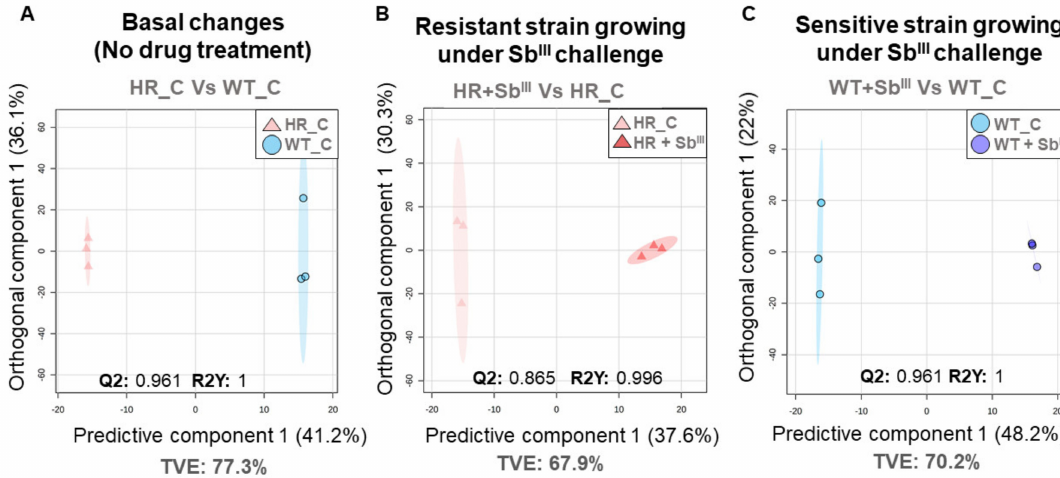
Figure 9. Supervised multivariate analysis indicating a clear inter-class discrimination. The score plot from Orthogonal partial least squares discriminant analysis (OPLS-DA) are represented by individual comparison. The data from three biological repeats were analyzed. ( A ) OPLS-DA score plot for the basal antimony resistant phenotype changes. ( B ) OPLS-DA score plot for the resistant strain responding to Sb III . ( C ) OPLS-DA score plot for the sensitive strain responding to Sb III . All models were successfully validated by one thousand permutations getting optimal Q2 and R2Y scores without any evidence of overfitting. Each individual marker represents a biological replicate. Total variance explained (TVE) in summarized. The 95% confidence ellipse using Hotelling T-squared is represented.